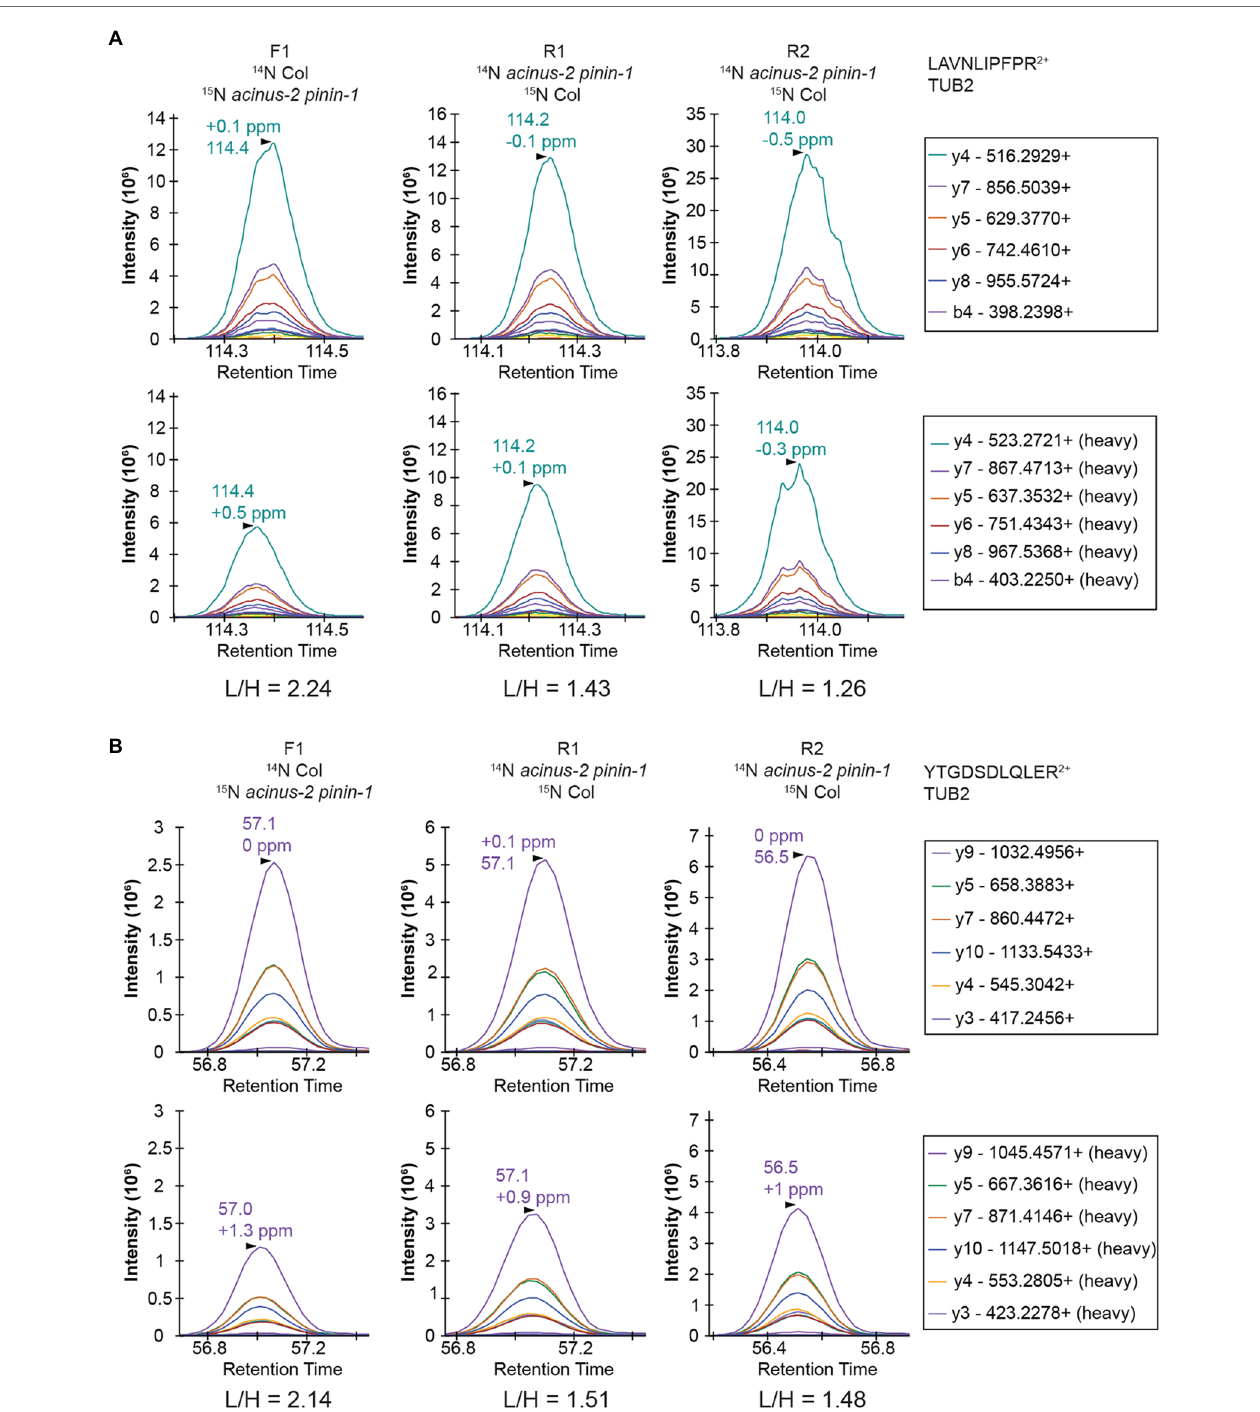
FIGURE 5 | PRM quantification on TUBULIN2. Peptides “LAVNLIPFPR” (A) and “YTGDSDLQLER” (B) from TUB2 were quantified in three samples. The six most abundant fragment ions are annotated with mass in the right legend with the order from most to the least abundant. The light and heavy peptides generate the same pattern of fragment ions with different